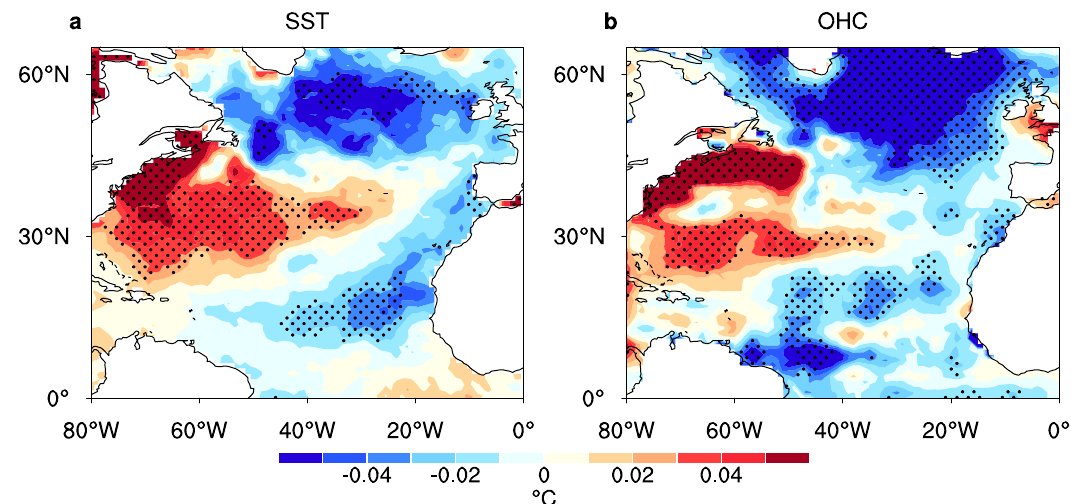
Fig. 3 Long-term trends in the North Atlantic Ocean. Long-term trends in the a SST (units: °C yr − 1 ) and b OHC (units: °C yr − 1 ) in the North Atlantic Ocean during the dry season for the time period 2003 – 2019. Stippling indicates passing the Mann – Kendall test at the 0.1 signi fi